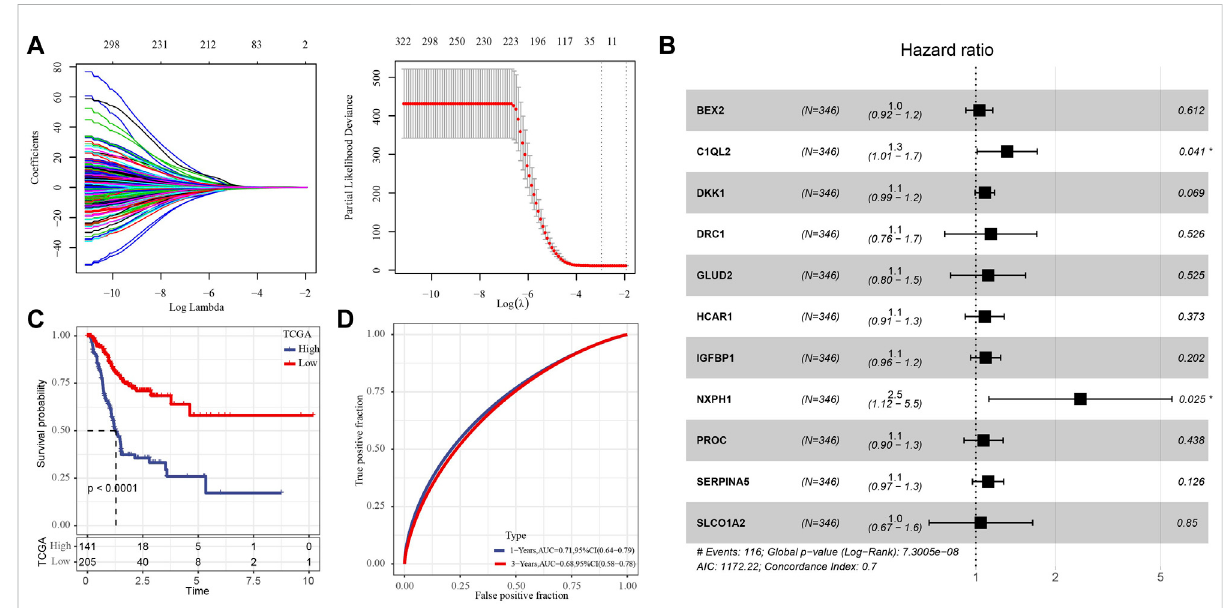
FIGURE 1 Development of prognostic signature composed of key HRD score-related genes. (A) The key genes were screened from 176 HRD score relatedgenesbyLassoregressionanalysis. (B) ForestmapofmultivariateCoxregression analysis of11genes. (C) Kaplan-Meiersurvivalanalysis offor the high- and low-risk group in TCGA with 346 GC cases. (D) The ROC curve of the risk score of GC in